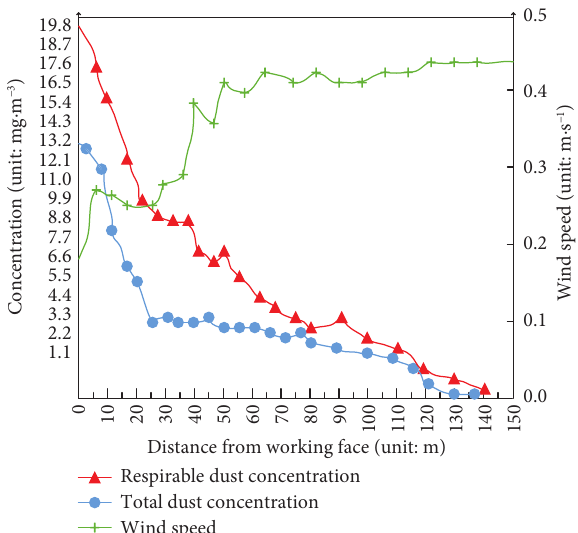
Figure 16: The real-time data of working face distance, wind speed, and dust